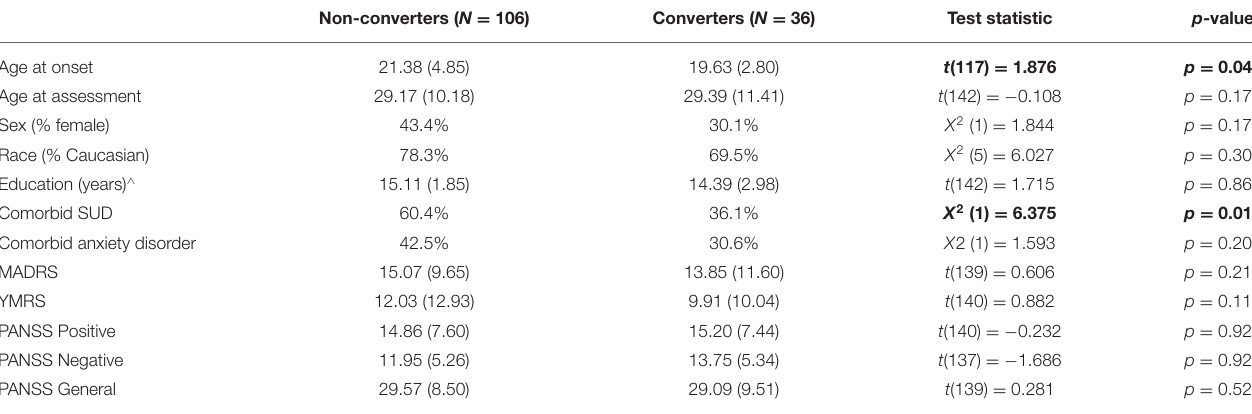
TABLE 1 | Demographic and clinical variables by conversion